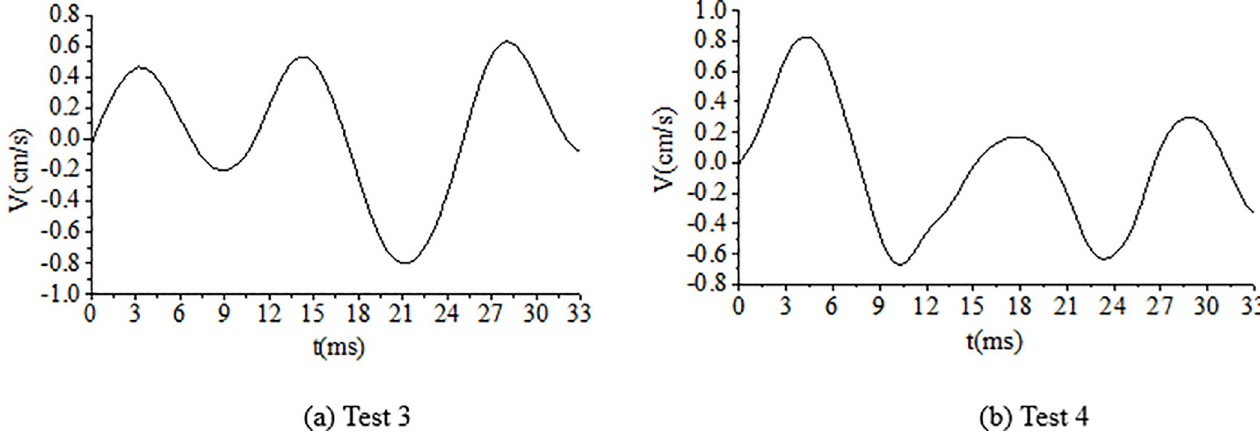
Fig 15. Vibration velocity curves of blasting signals for cut holes for a delay time of 3 ms.